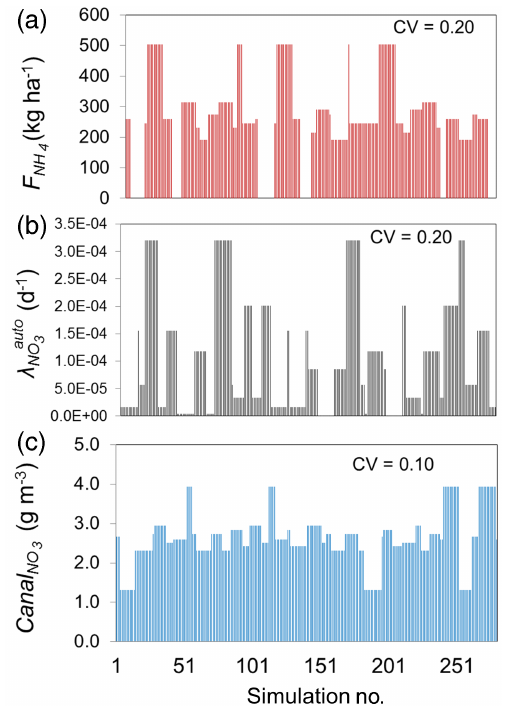
Figure 5. Values of (a) fertilizer loading F NH and (b) first-order rate constant of autotrophic denitrification λ auto (1/day) and (c) nitrate concentration of canal water Canal NO (mgL − 1 ) for the Rocky Ford Highline canal command area, for each of the 280 simulations in the revised Morris SA